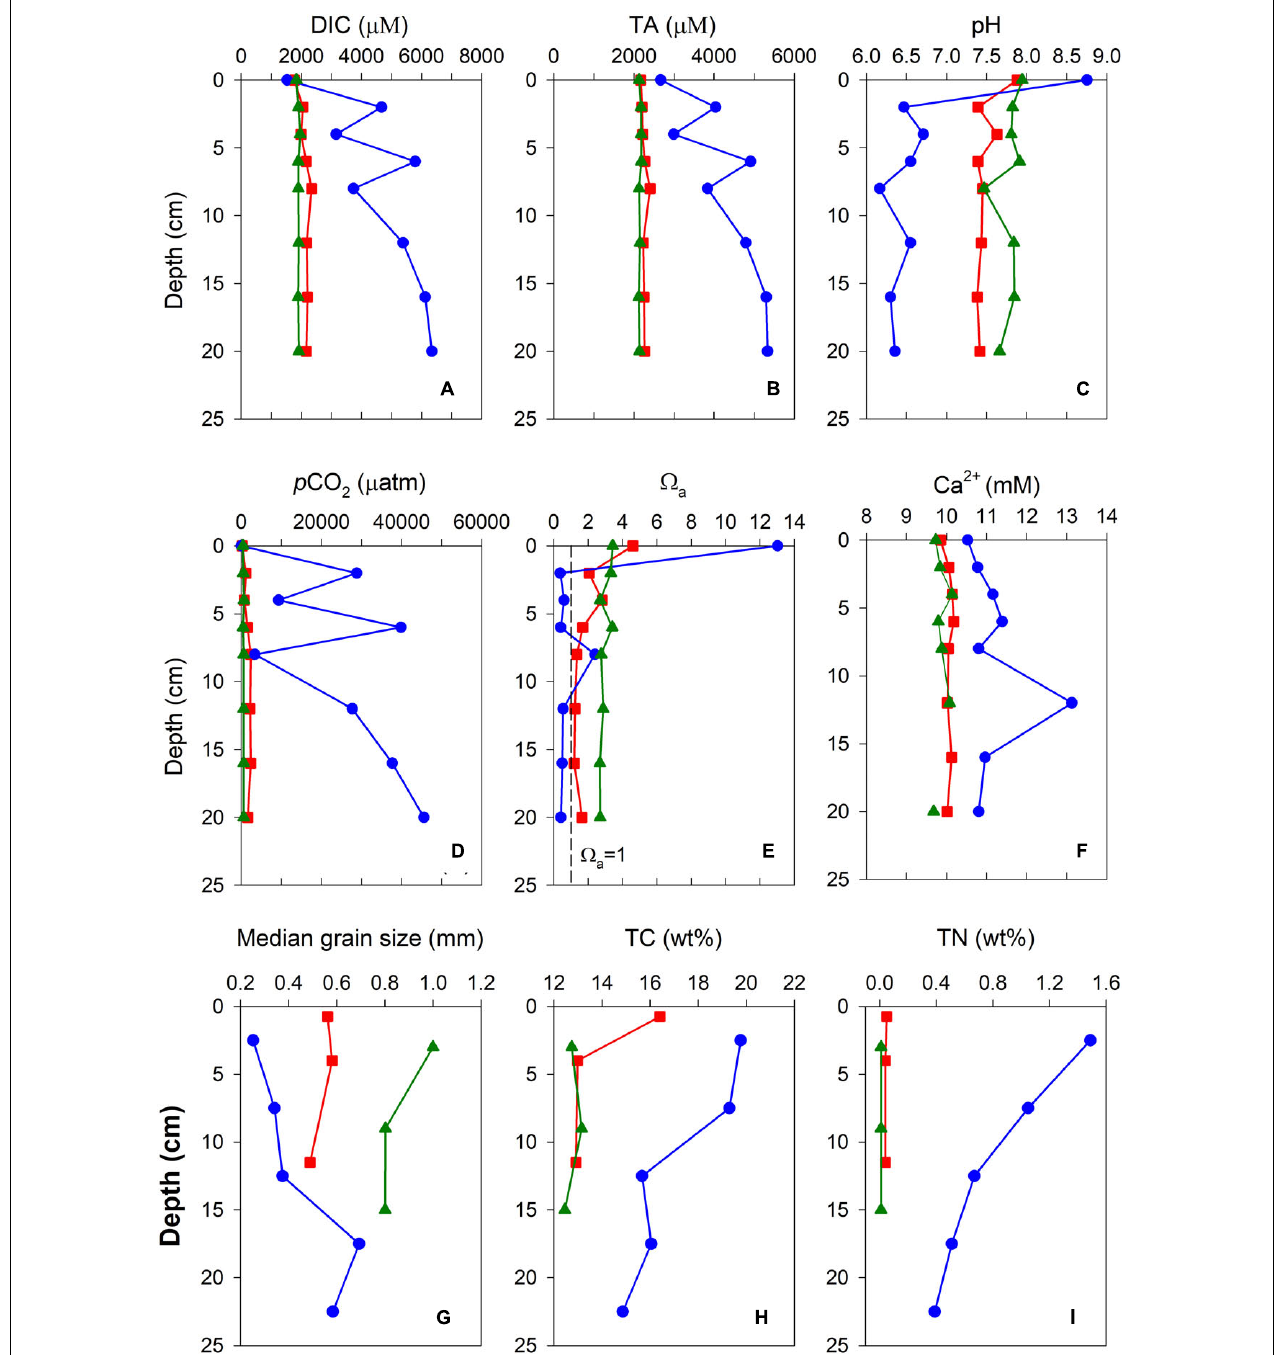
FIGURE 4 | Vertical porewater profiles of (A) DIC, (B) TA, (C) p CO 2 , (D) pH, (E) (cid:127) a , and (F) Ca 2 + , and vertical distributions of (G) median grain size, (H) total carbon, and (I) total nitrogen in the sediment cores collected on the northern shore (NS, red squares), on the southern shore (SS, green triangles), and in the inner lagoon (IL, blue circles) of Dongsha